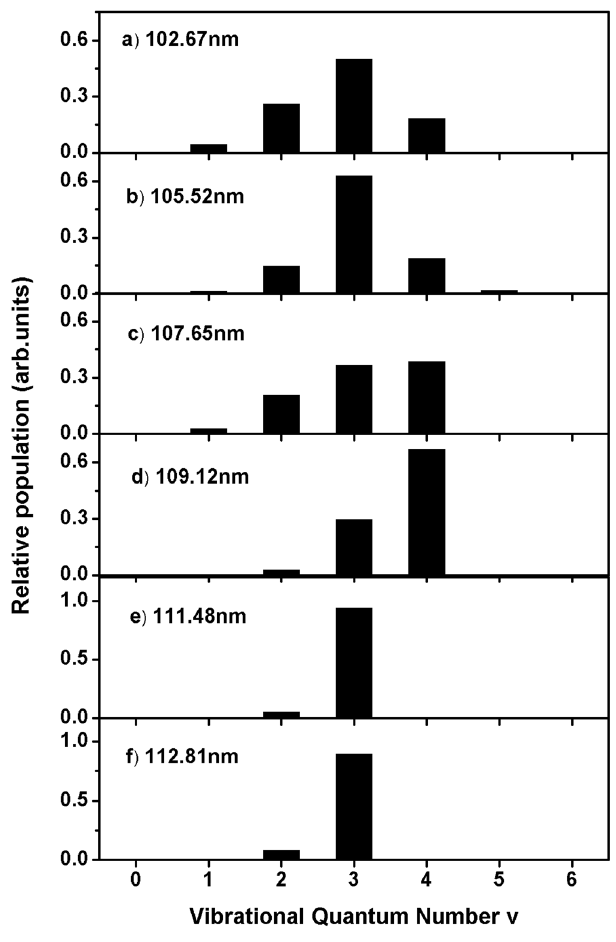
Fig. 4 Vibrational state distributions of H 2 from H 2 O photolysis. Relative populations of different vibrational states of the H 2 (X) products in the O( 1 S) + H 2 channel from the O( 1 S) detection at six photolysis wavelengths. The raw data are provided as a Source Data fi